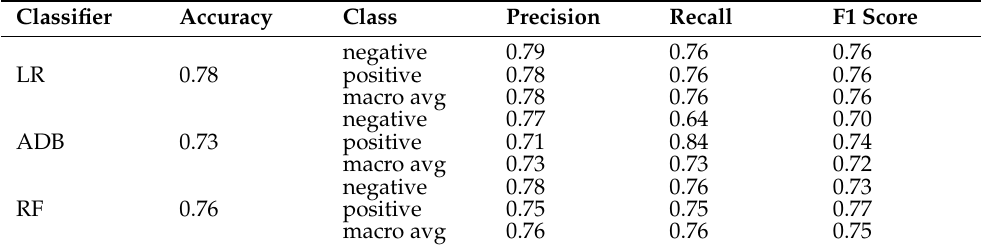
Table 9. Experimental results of ML models with original sentiments using a feature